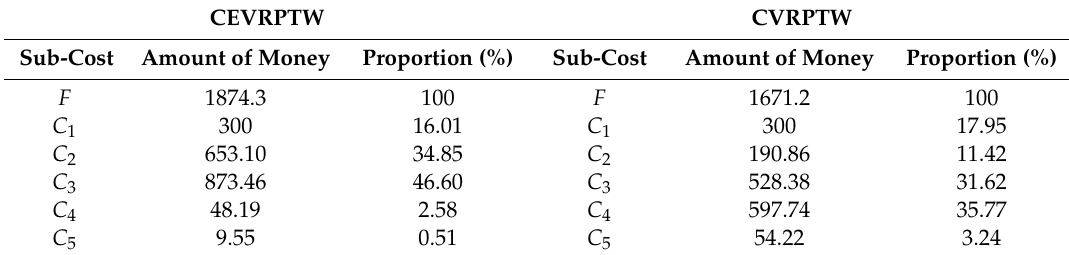
Table 10. The proportion of the cost when carbon price is 0.25.